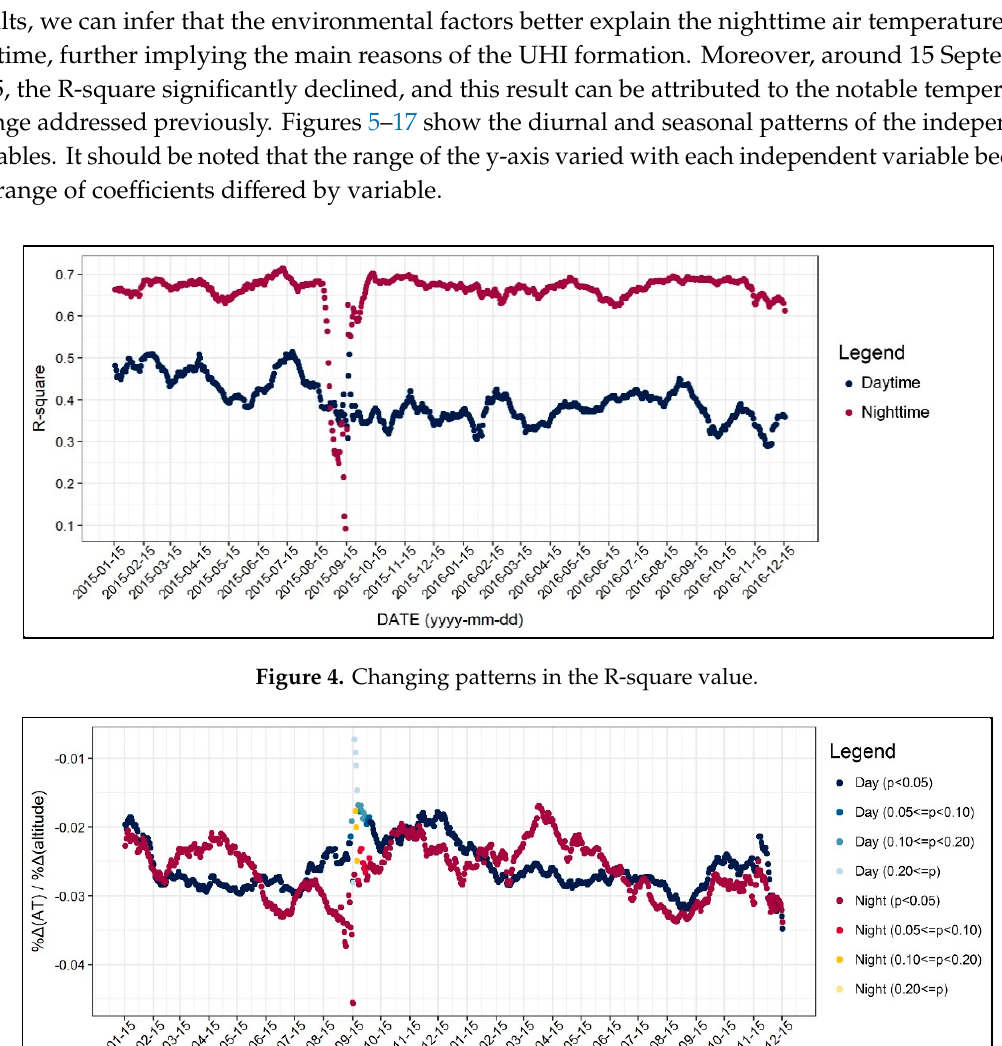
Figure 5. Changing patterns in the regression coefficients and their significances (Altutude of the automatic weather station (AWS)).